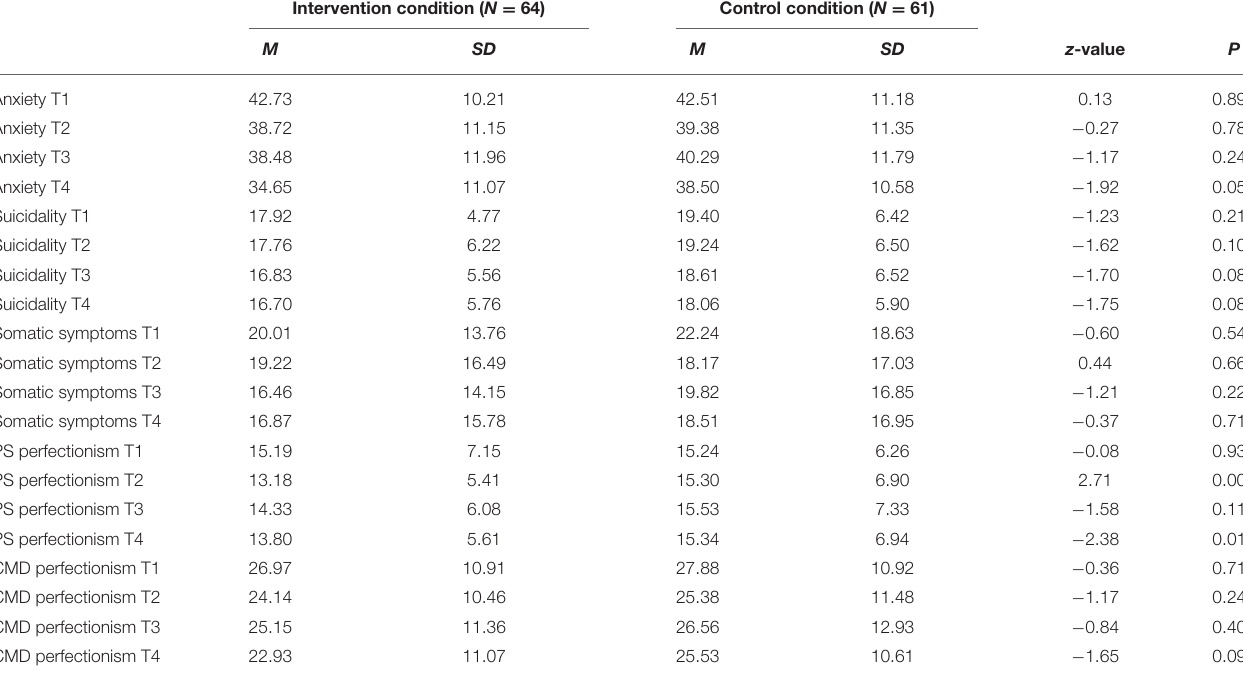
TABLE 1 | Means, standard deviations, and z-values for differences on anxiety, suicidality, somatic symptoms, and perfectionism (PS and CMD) between the intervention and control